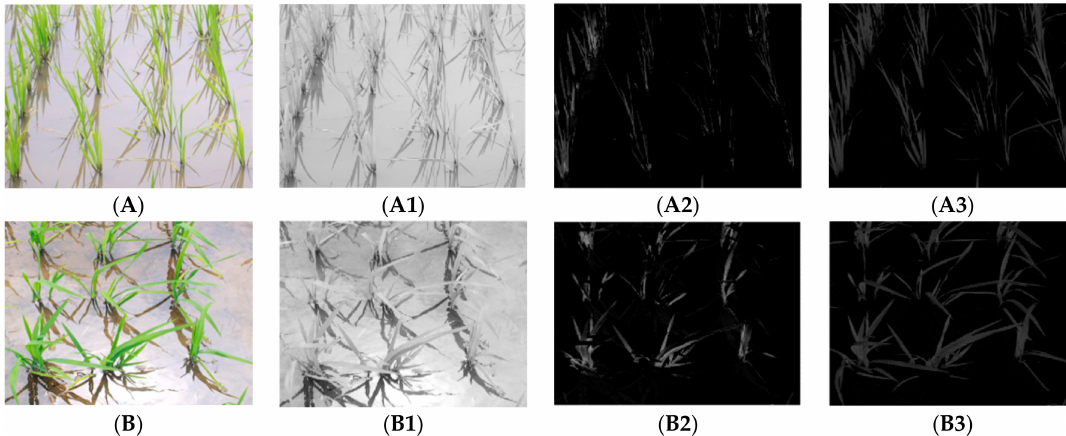
Figure 10. The rice seedling images and the processing results by applying the different graying processing methods: ( A ) the original image with shadow on a cloudy day; ( A1 – A3 ) the corresponding results of G component, ExG and 2 Cg-Cr-Cb graying methods; ( B ) the original image with highlights on a sunny day; ( B1 – B3 ) the corresponding results of G component, ExG and 2Cg-Cr-Cb graying